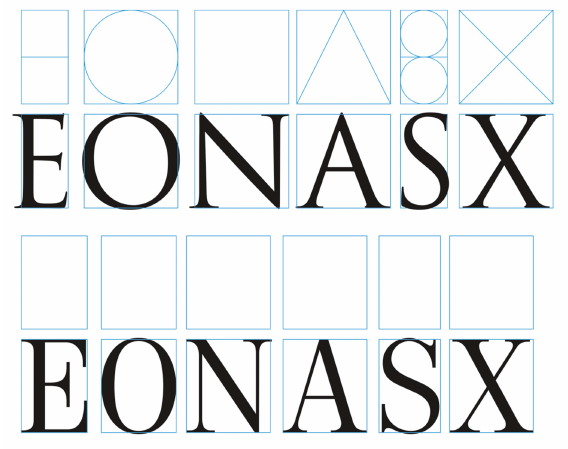
Figure 2. Classical and ‘Modern’ letter proportions (adapted from (Cheng, 2006)). The typeface ‘Trajan’ by Carol Twombly (up) and the typeface ‘Neoplanta BG’ by Stjepan Fileki (down).